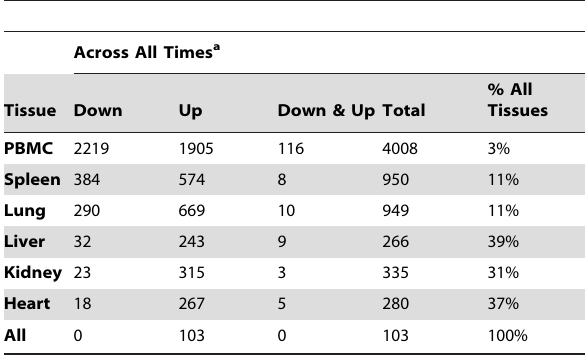
Table 2. Tissue specific counts of differentially expressed probesets aggregated across time